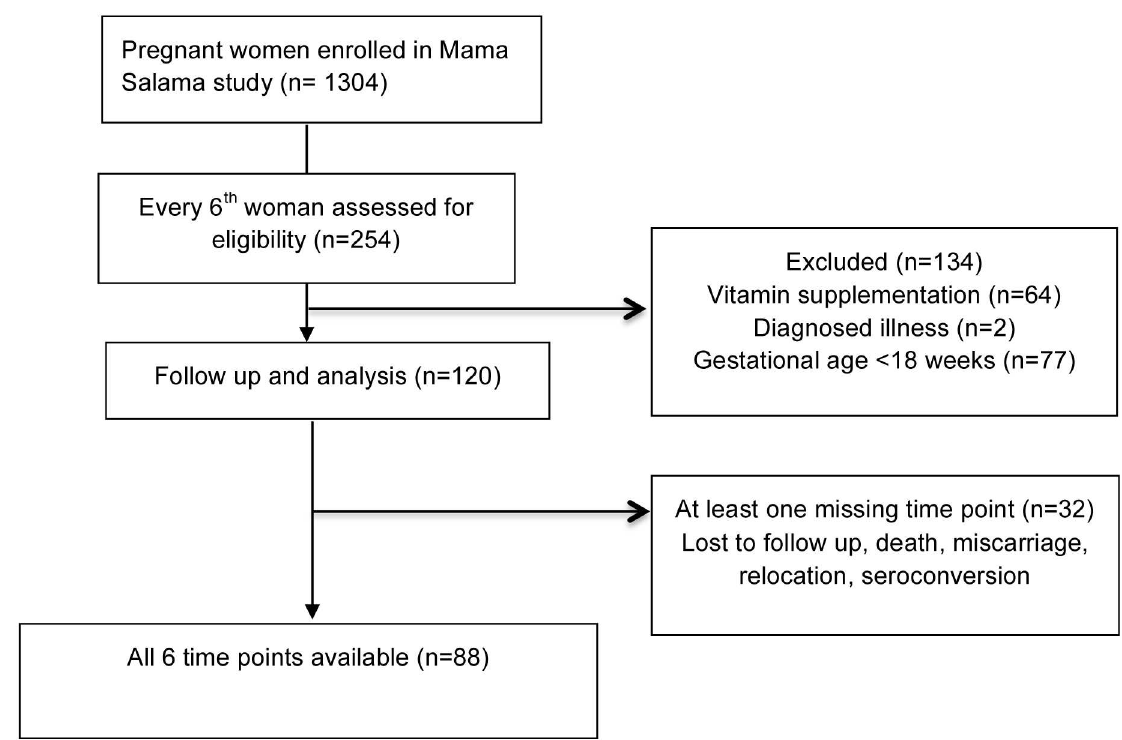
Fig 1. Flow diagram of participants in the study. The sub study assessedevery 6th participantin the parent study for eligibility (254 participants). One hundredand twenty paticipantswere enrolledand followedup to 24 weeks postpartum. Of 120 enrolled participants, 32 did not completeall six study visit measurements due to a numberof reasons including participantunableto be contacted, miscarriage, death, relocation and seroconversion.